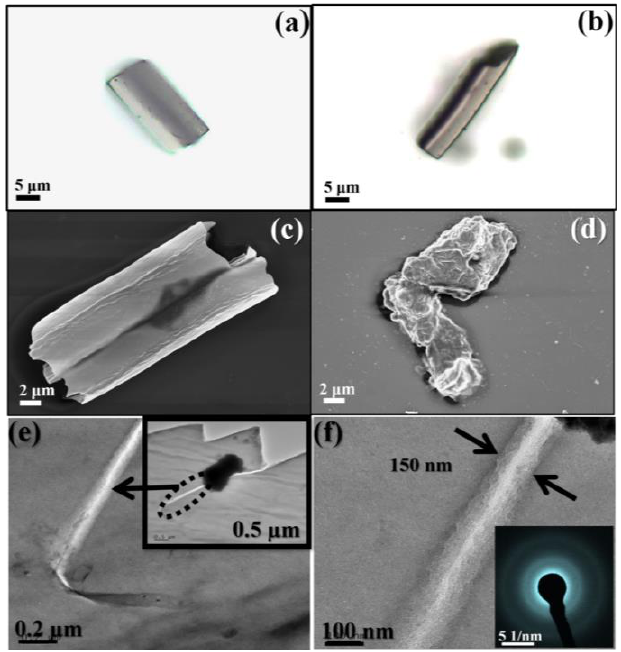
Figure 3. Typical optical micrographs @ 100 × for ( a ) GLNRs and ( b ) high strain rate (HSR) GLNRs, respectively, ( c , d ) FESEM images and ( e , f ) HRTEM images of fractured HSR GLNR.